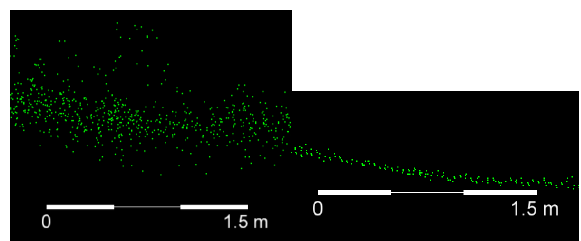
Figure 6. Cross-section for the same part of the grass (Left: MLS, Right: UAV)